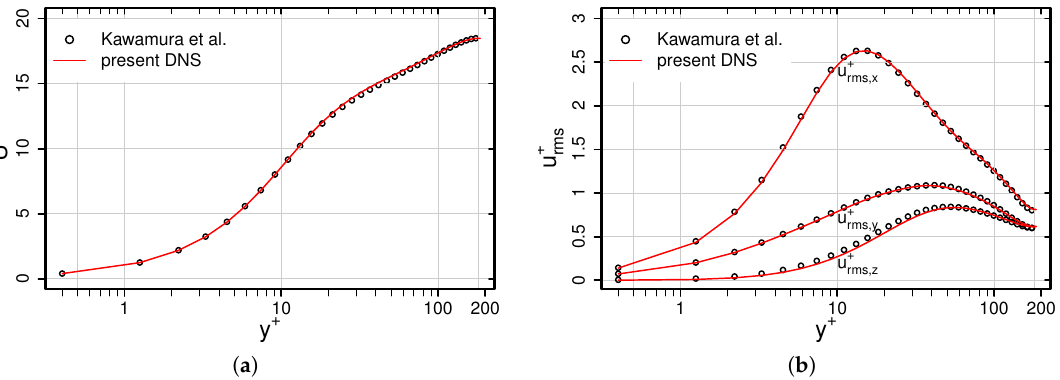
Figure A2. Mean ( a ) and RMS ( b ) velocities as a function of the non-dimensional wall distance y + . Comparison of results from the present DNS with the reference data of